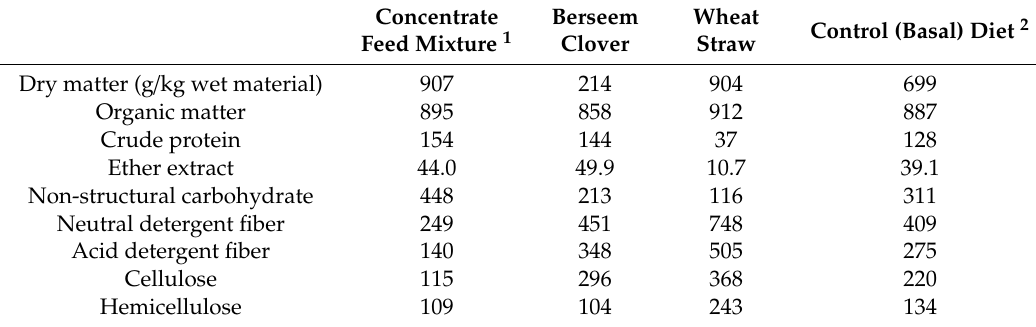
Table 1. Chemical composition of experimental control diet fed to the Nubian goats (g / kg DM basis unless otherwise stated).